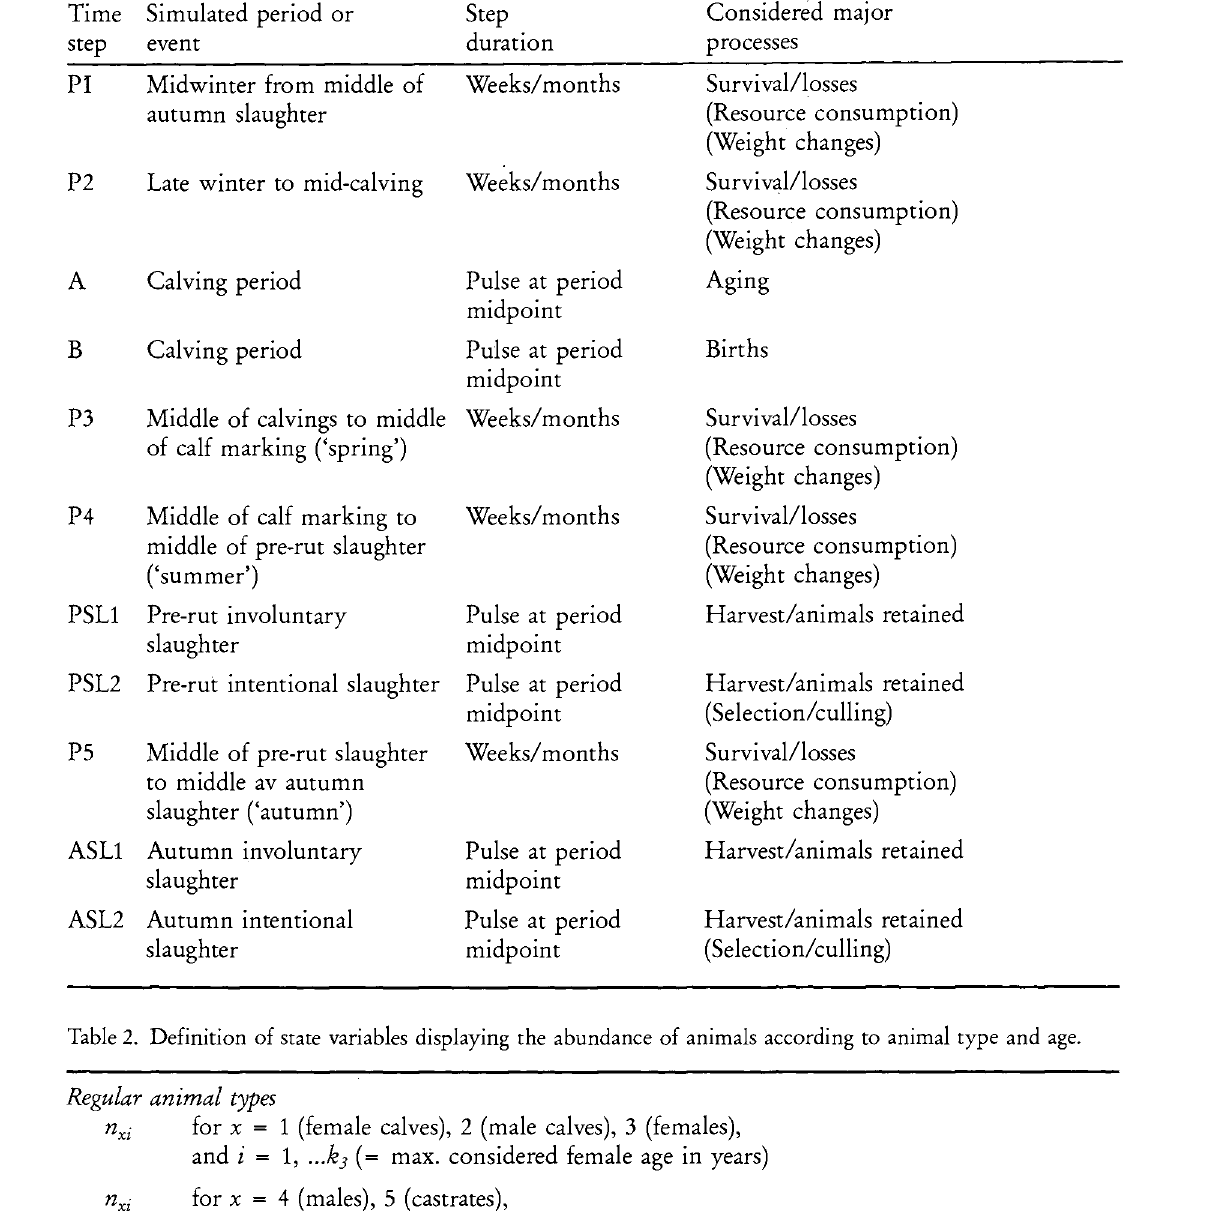
Table 1. Description of the 11 simulation time steps deviding ; up the year (Secondary processes in parentheses)..